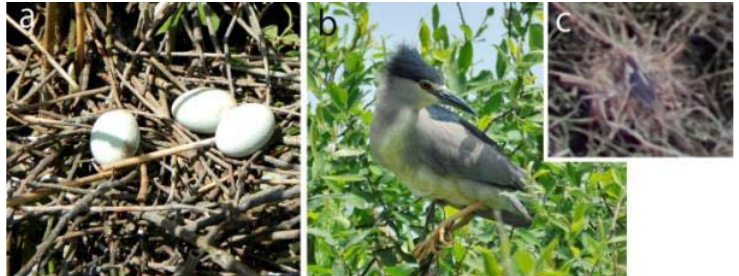
Figure 4. The ( a ) nest of the Black ‐ crowned Night Heron, ( b ) the adult bird, and ( c ) an adult bird, sitting on its nest—details of an orthophoto (captures by Edina Morvai and Gábor Bakó).